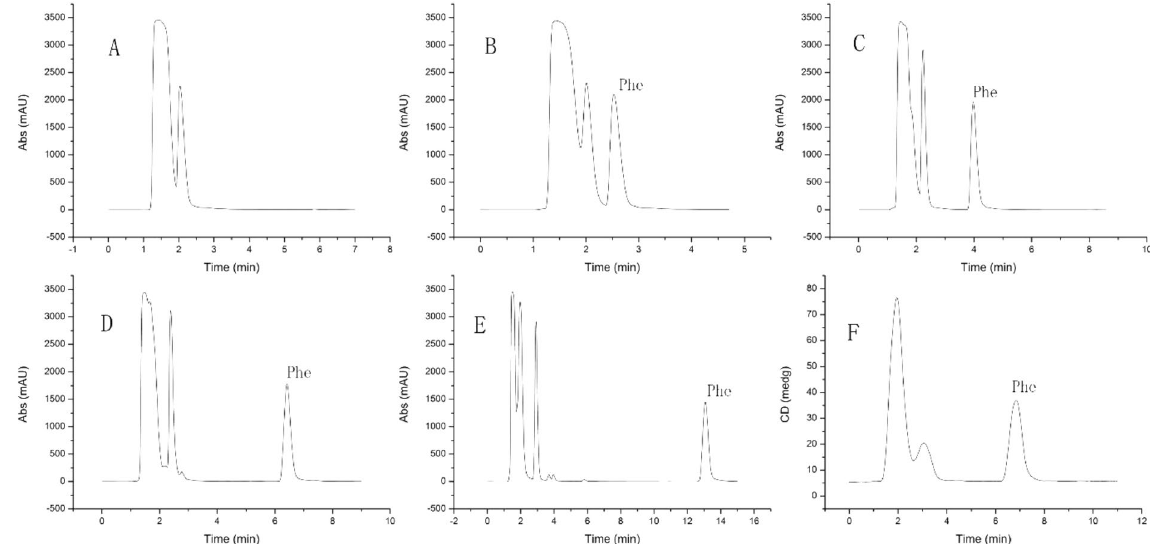
Figure 4. Separation of the L-phenylalanine from of the amino acid mixture using different mobile phases. (Water: Acetonitrile = ( A ) 80:20, ( B ) 90:10, ( C ) 95:5, ( D ) 98:2, ( E ) 100:0, DAD detector with a wavelength of 220 nm; ( F ) The CD spectrum of separation of amino acid mixture with CD detector using a mobile phase of A:B = 98:2; 0.5 mg/g of each amino